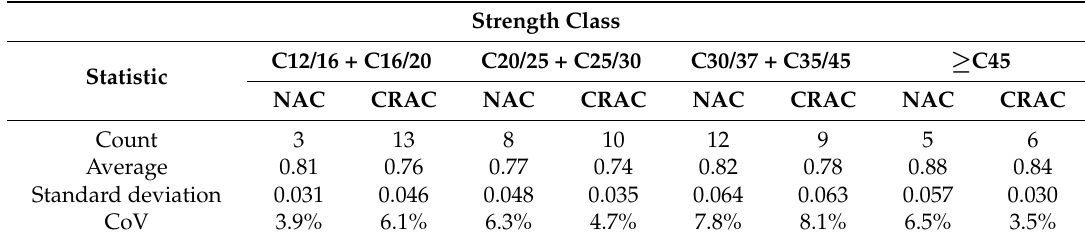
Table 4. Statistics of K versus strength class.